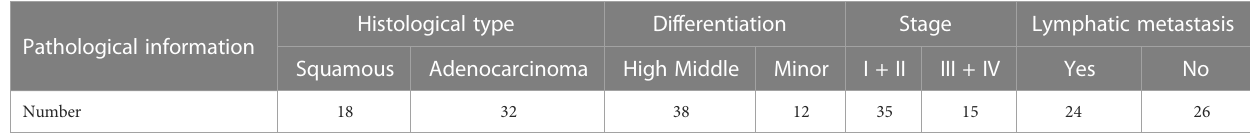
TABLE 2 Clinically-relevant pathological